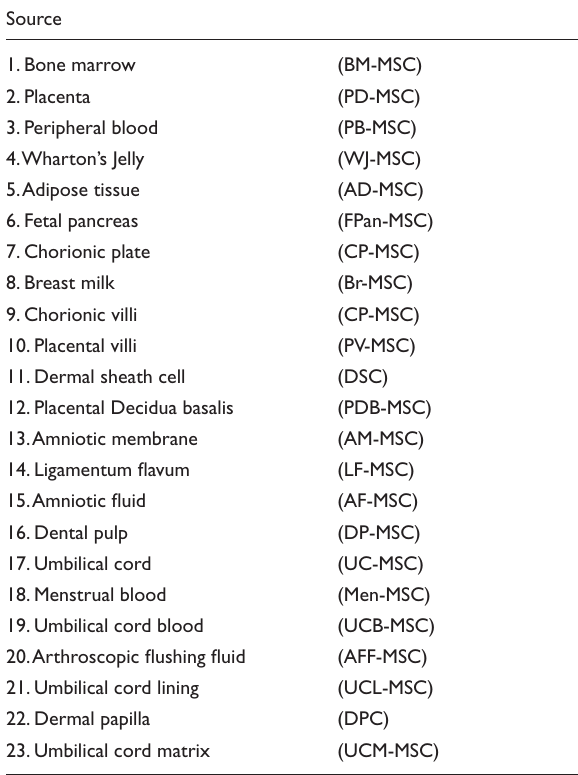
Table 1. The source of MSCs in the